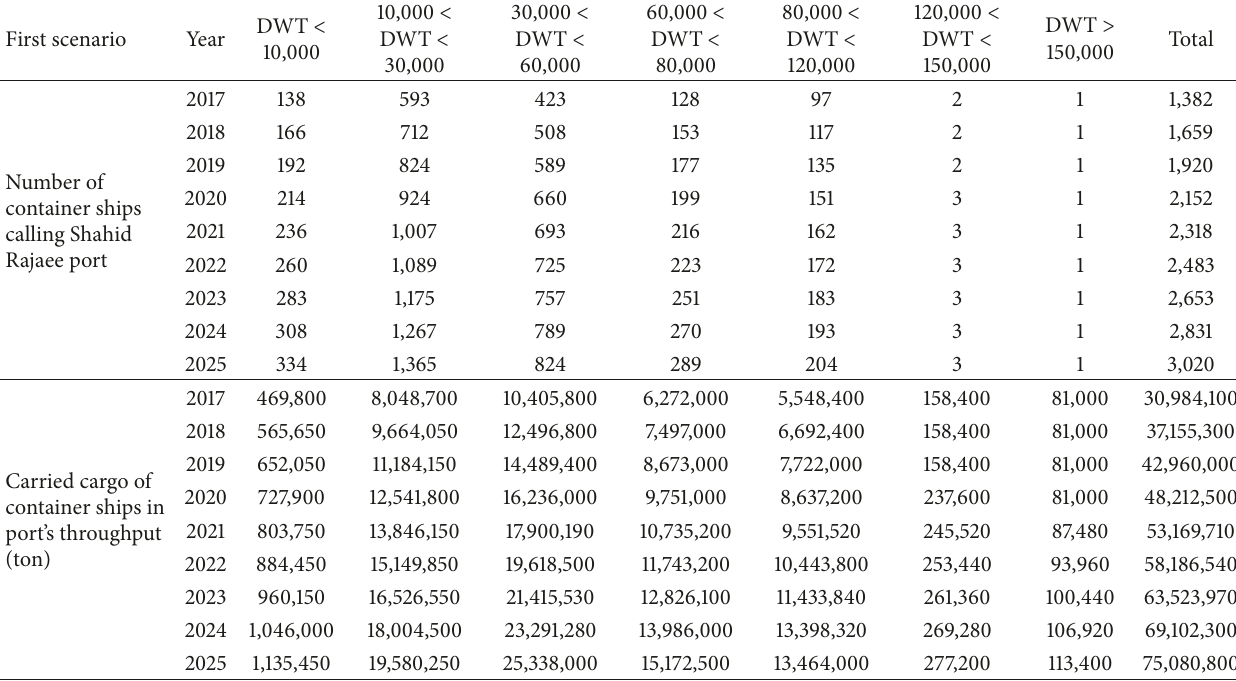
Table 2: Number of container ships and their carried cargo (ton) in port container throughput (predicted from 2017 to 2025) based on the first scenario.